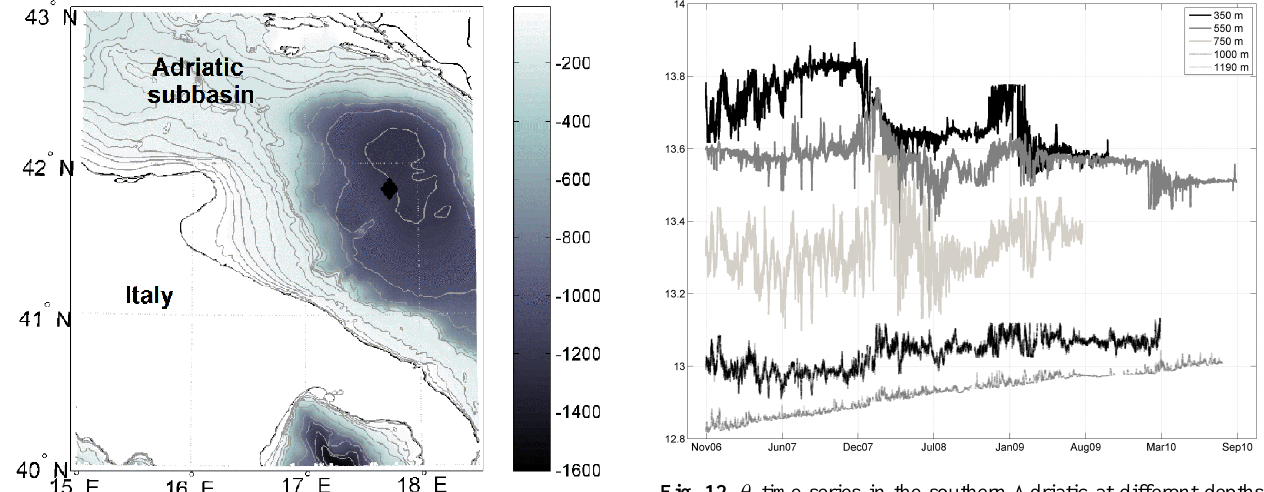
Fig. 12. θ time series in the southern Adriatic at different depths (see